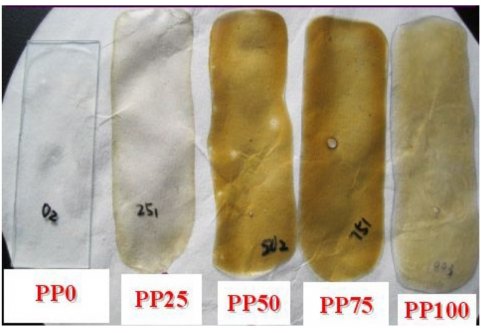
Figure 5. Appearance of the coatings immersed in seawater for 30 days.